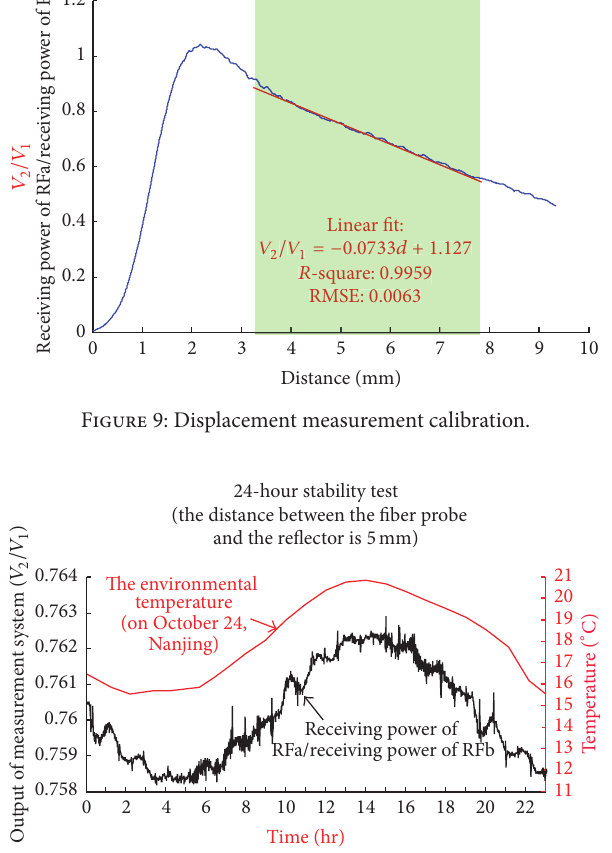
Figure 10: Measurement system stability test result.